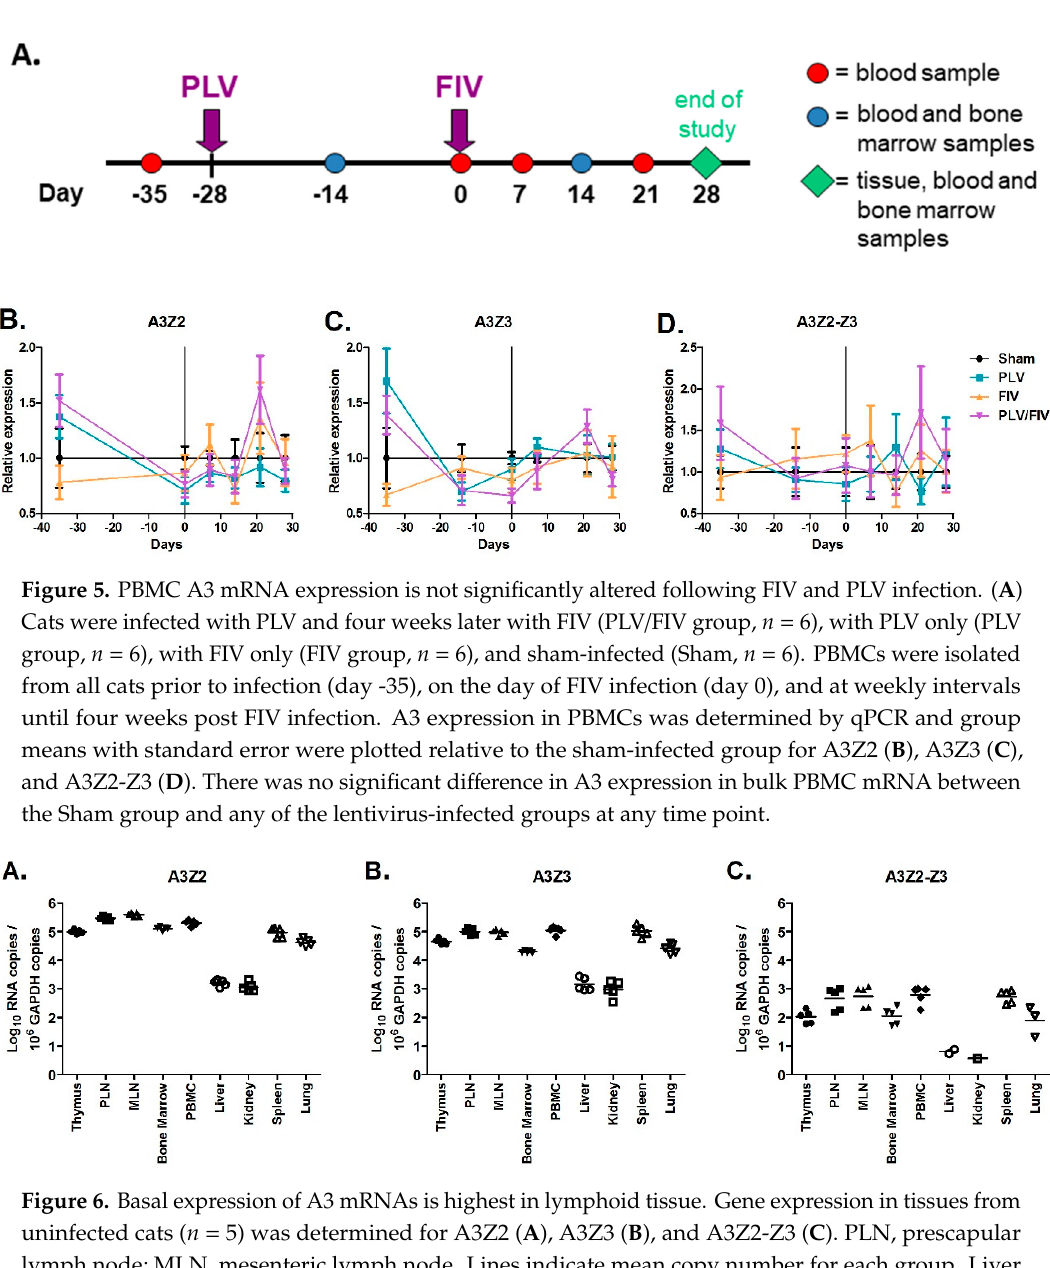
Figure 6. Basal expression of A3 mRNAs is highest in lymphoid tissue. Gene expression in tissues from uninfected cats ( n = 5) was determined for A3Z2 ( A ), A3Z3 ( B ), and A3Z2-Z3 ( C ). PLN, prescapular lymph node; MLN, mesenteric lymph node. Lines indicate mean copy number for each group. Liver and kidney had significantly lower expression than all other tissues for all A3 mRNAs ( p < 0.05).